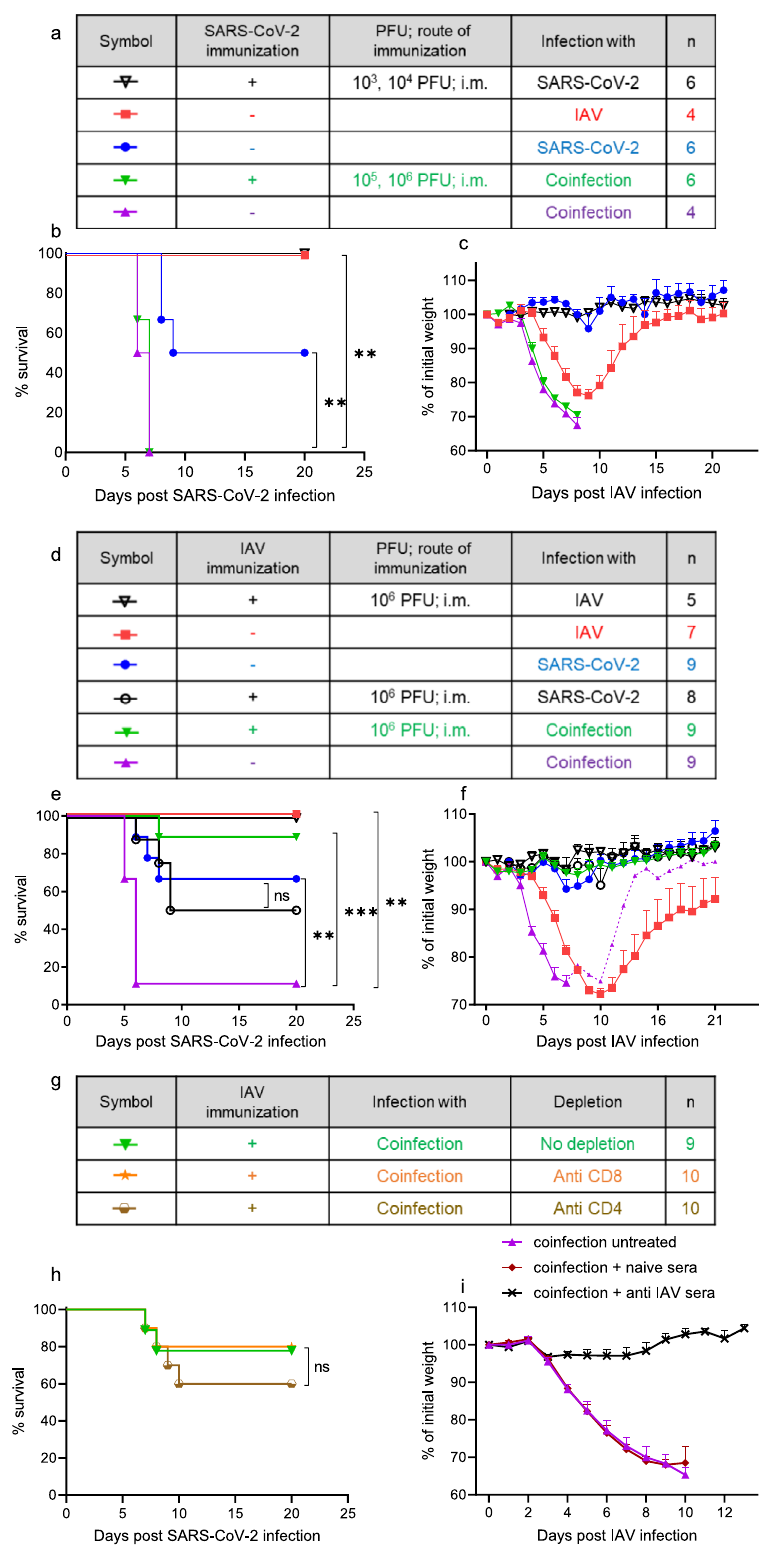
antibodies in the protection of coinfected mice, we performed passive transfer of anti-IAV sera to coinfected mice. Anti-IAV antibodies rescued the coinfected mice (Fig. 4i), indicating that the protection was indeed antibody dependent.